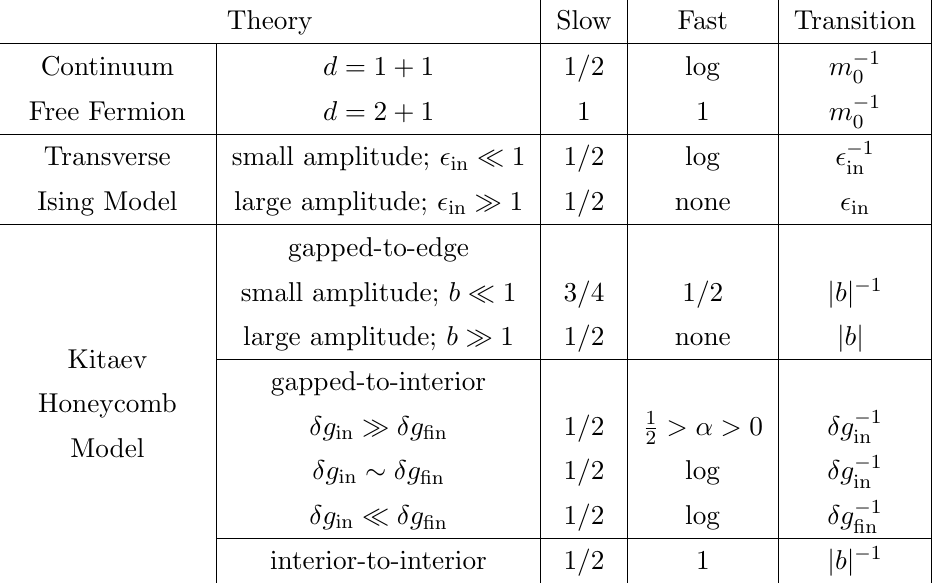
Table 3 . A summary of our results for the scaling behaviour in critical quenches of the transverse (cid:12)eld Ising model (2.9) and the Kitaev honeycomb model (2.20). We have also included the analogous results for a free fermion in two and three dimensions, for comparison. The columns ‘Slow’ and ‘Fast’ indicate the scaling exponent in the response, i.e., h (cid:22) (cid:31)(cid:31) i di(cid:11) (cid:24) ( J(cid:14)t ) (cid:0) (cid:11) , for the slow and fast quench regimes | ‘log’ indicates a logarithmic scaling was found and ‘none’ indicates the fast scaling regime disappears. The column ‘Transition’ indicates the approximate value of J(cid:14)t when the scaling makes a transition between the two scaling regimes, or the minimum value for the slow scaling when there is no fast scaling regime. For the continuum free fermion, we are indicating the value of (cid:14)t at this